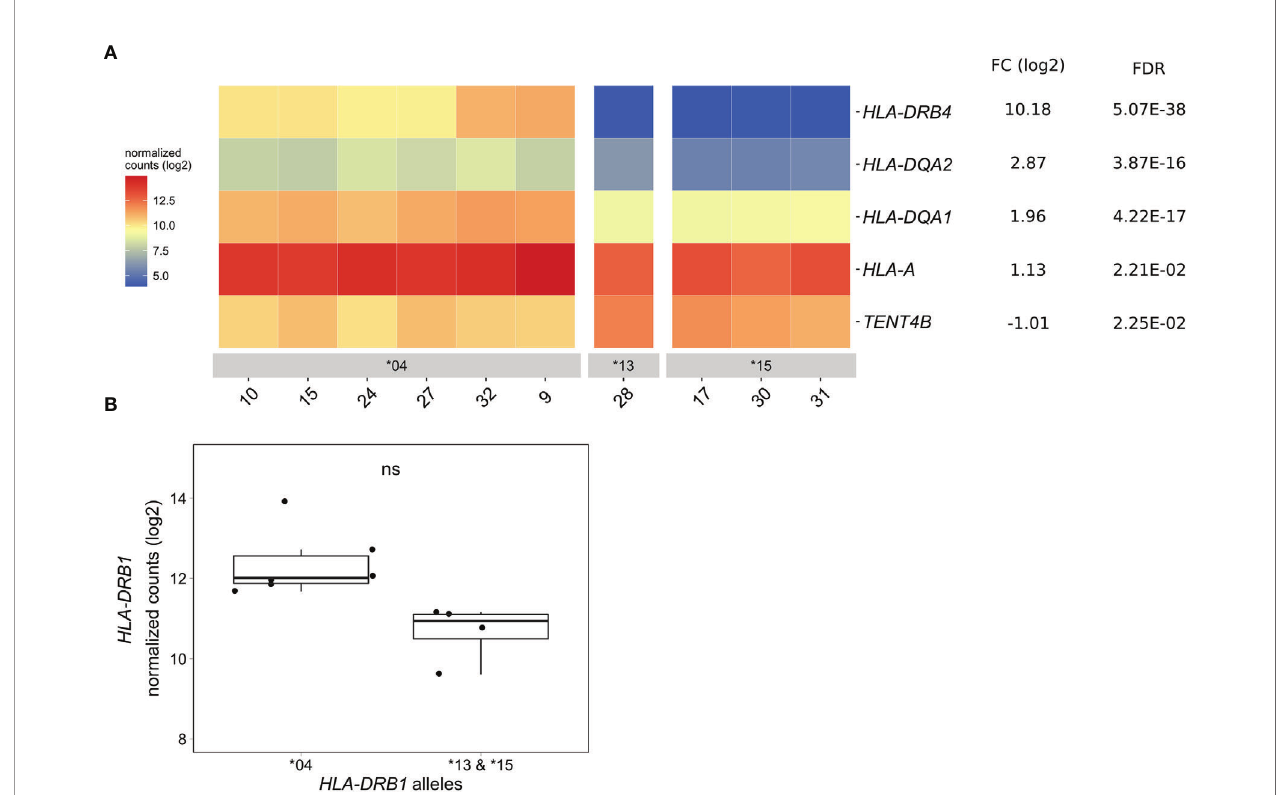
FIGURE 4 | Differentially expressed genes in CD14+ monocytes of HLA-DRB1 SE-positive versus SE-negative healthy individuals. (A) Heat map of differentially expressed genes (log transformed normalized gene counts) in CD14+ monocytes of HLA-DRB1 SE-positive [*04 ( n = 6)] and SE-negative [*03:01/*13:01 and *03:01/ *15:01 ( n = 4)] individuals. Genes shown in red have higher gene counts and those shown in blue have lower gene counts for the contrast SE+ vs. SE-. (B) HLA- DRB1 gene expression in CD14+ monocytes of HLA-DRB1 SE-positive [*04 ( n = 6)] and SE-negative [*03:01/*13:01 and *03:01/*15:01 ( n = 4)] individuals. FC, fold change; ns, non-signi fi cant adjusted P -value (FDR).